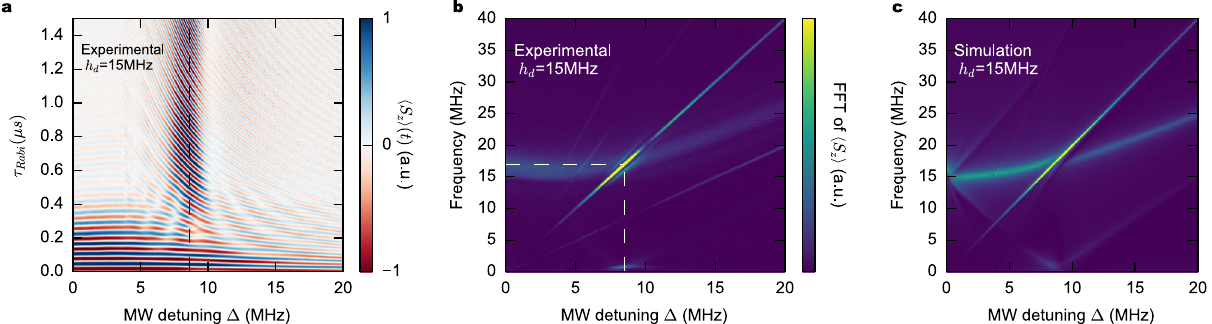
Figure 6. Rabi dynamics as a function of detuning at fixed drive level h d . ( a ) Contour plot showing S z as 2 (cid:31) (dashed), the Rabi oscillations are a function of pulse length τ Rabi and microwave detuning (cid:31) . At F R = optimally sustained by the image pulse. ( b ) The FFT of ( a ) shows an intense peak where the optimum protection is achieved (dashed lines). ( c ) A simulated FFT using the rotating wave approximation and the parameters of ( b ), is in agreement with the experimental